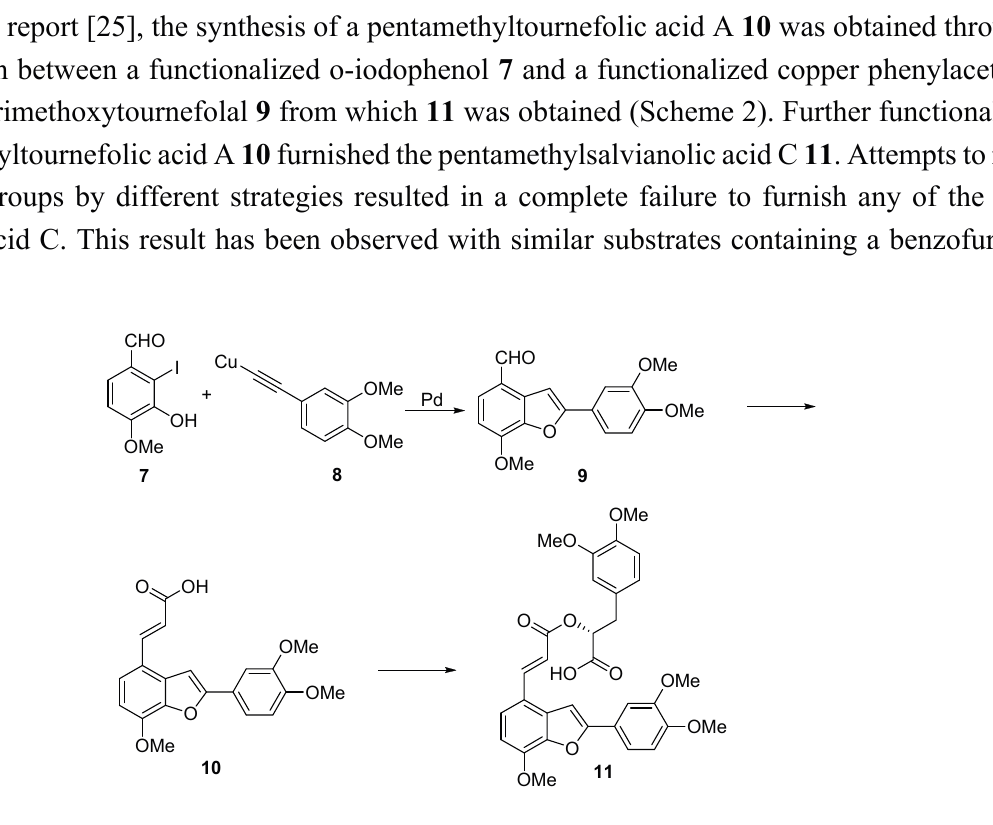
Scheme 2. Synthetic route to pentamethylsalvianolic acid C 11